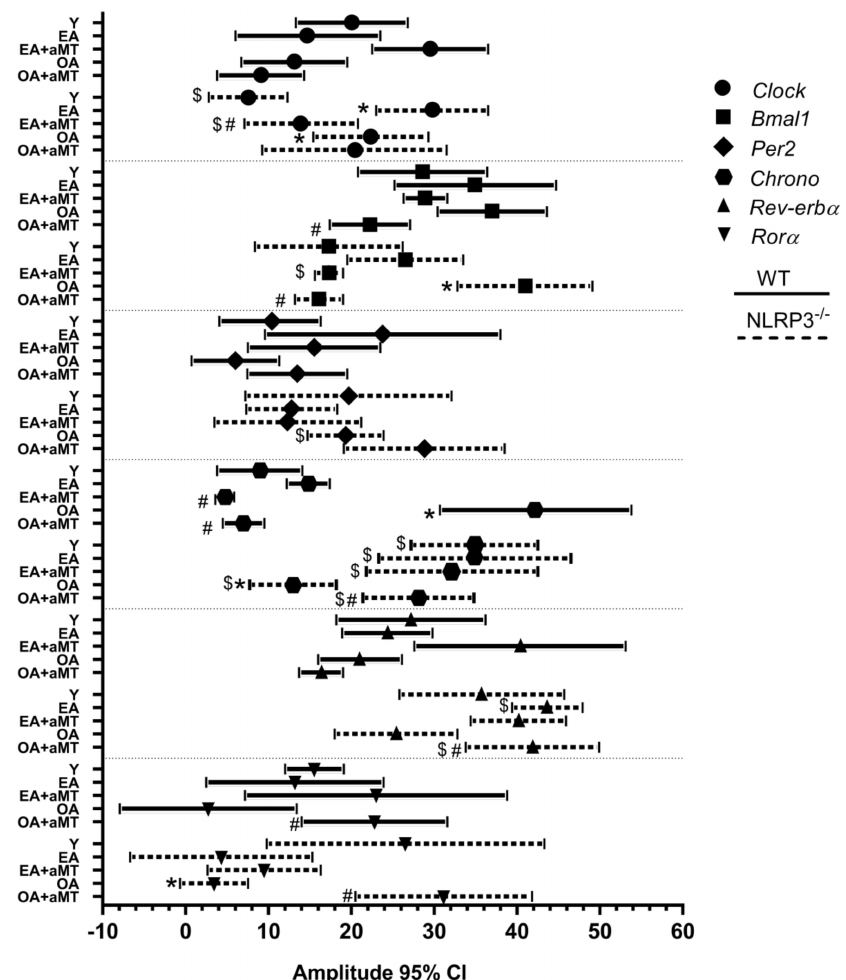
Figure 4. Amplitude chart showing peaks of fitted 24 h cosine for clock genes analyzed in the heart of WT and NLRP3 − / − mice during aging and melatonin treatment. Amplitude of clock genes Clock , Bmal1 , Per2 , Chrono , Rev-erb α , and Ror α in hearts of young (Y), early-aged (EA), early-aged with melatonin (EA + aMT), old-aged (OA), and old-aged with melatonin (OA + aMT) wild type (solid line) and NLRP3 − / − mice (dashed line). Data are expressed as means ± confidence interval (CI) of the amplitude when p was ≤ 0.05 from the nonzero amplitude. Data of significant differences among the experimental groups were evaluated by overlapping of confidence interval and are detailed in Supplementary Table S2. * p < 0.05 vs. Y; # p < 0.05 vs. group without melatonin treatment; $ p < 0.05 vs. WT